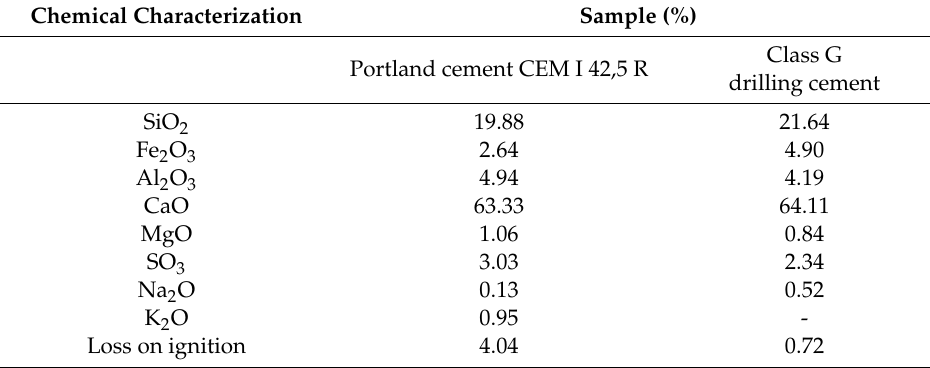
Table 1. Chemical characterization of Class G drilling cement and Portland cement CEM I 42,5R.